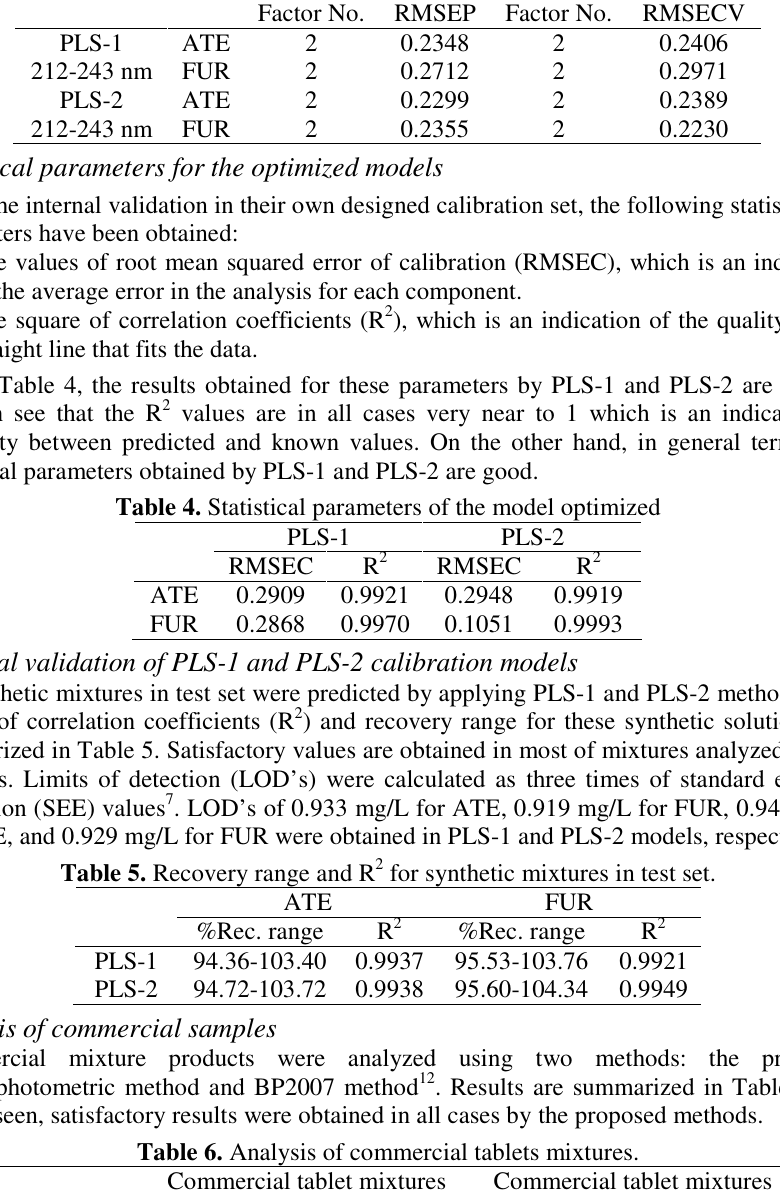
Table 3. Optimal number of factors, RMSEP and RMSECV values.